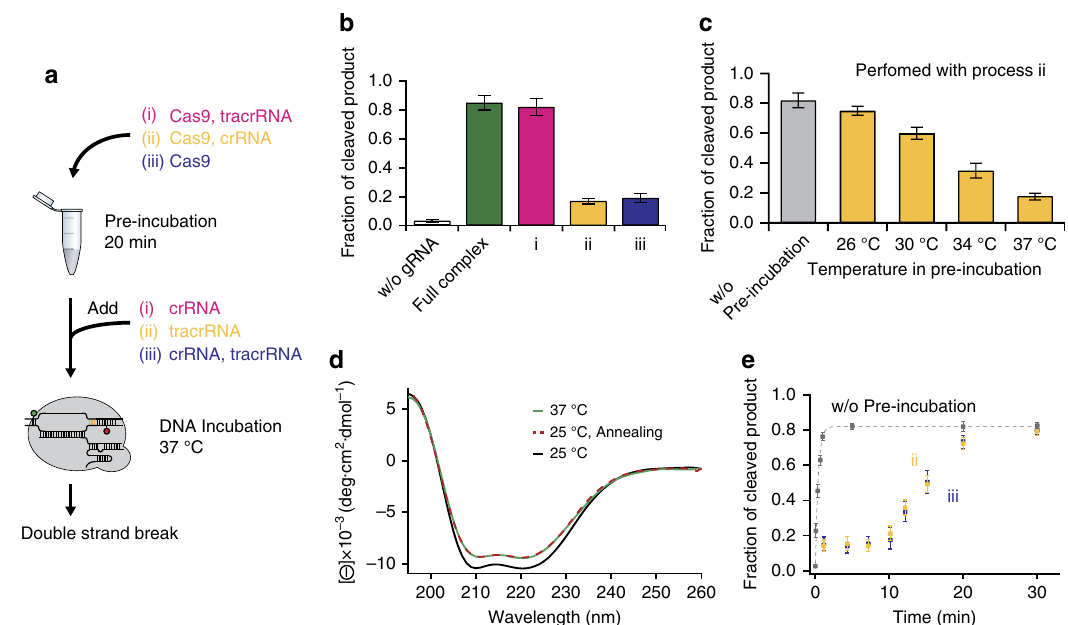
Figure 1 | Identification and quantification of inactive Cas9. ( a ) Three different procedures of our partial pre-incubation experiment. ( b , c ) Quantification of DNA cleavage efficiencies under different pre-incubating conditions: mixing process ( b ) or temperature during pre-incubation ( c ; mean ± s.e.m., n Z 5). ( d ) CD spectra of Cas9 without tracrRNA at 25 (cid:2) C (black) and 37 (cid:2) C (green). Annealing was performed from 37 (cid:2) C to 25 (cid:2) C at a cooling rate of (cid:2) 1 (cid:2) Cmin (cid:2) 1 (red dotted line). (e) Kinetic curves of DNA cleavage in the absence (grey) or presence (yellow: Cas9-crRNA, blue: Cas9 alone) of 37 (cid:2) C pre- incubation. DNA incubation and fluorescence measurement were conducted at 37 (cid:2) C for all plots in ( b , c , e ). Error bars in e represent